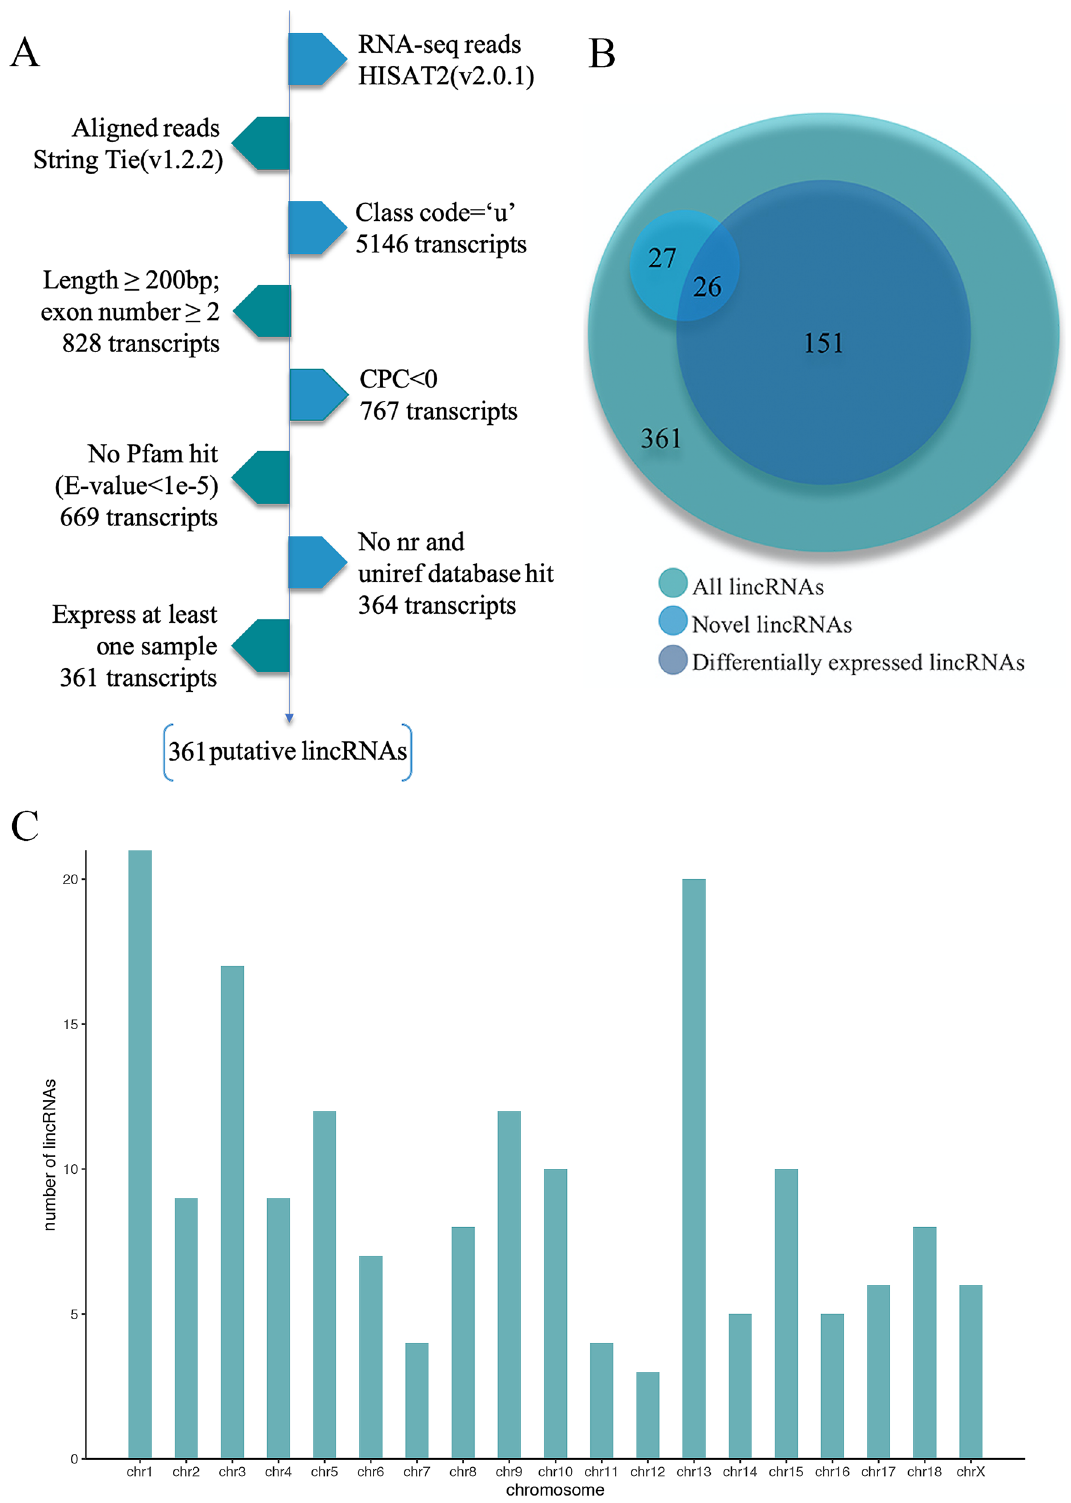
Figure 1. LincRNA analysis pipeline, classification and chromosome distribution. ( A ) LincRNAs identification pipeline. ( B ) Venn diagram of the proportion of different lincRNAs. ( C ) LincRNAs chromosome